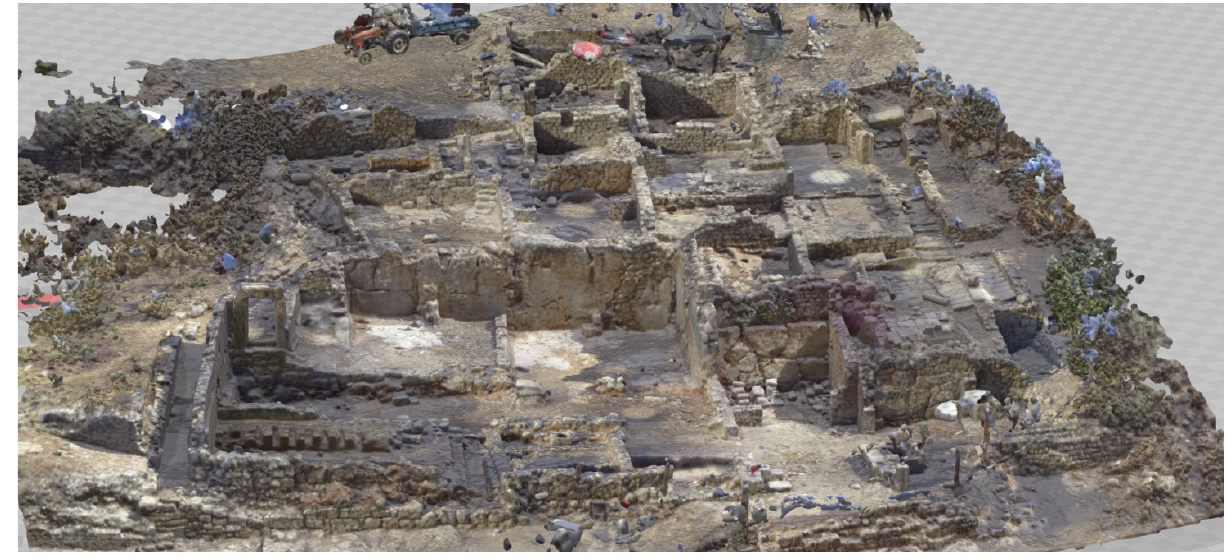
Figure 12. Polygonal